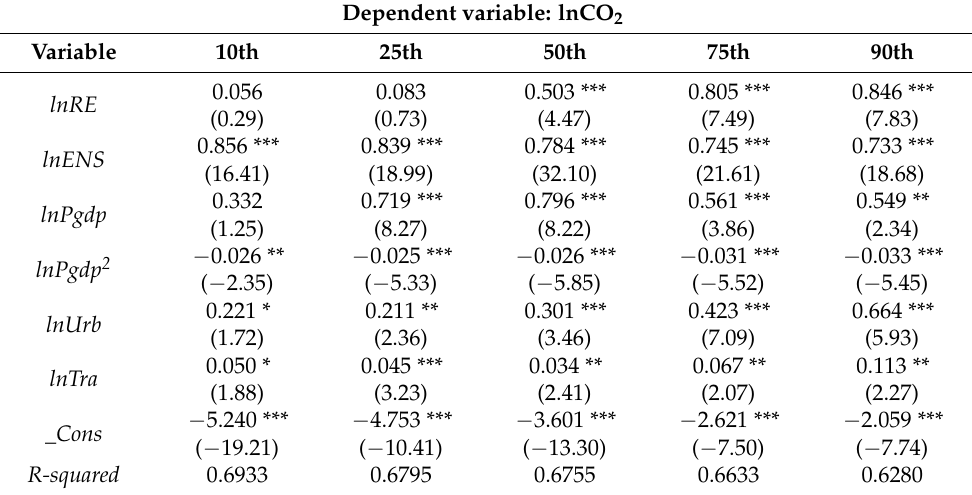
Table 8. Two-step quantile regression